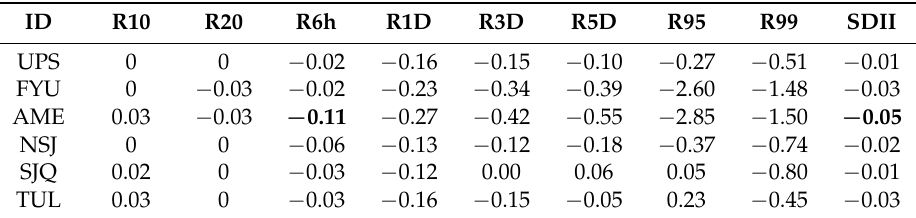
1 Trend slope unit is mm/year. Significant ( α = 0.05) trends are highlighted in